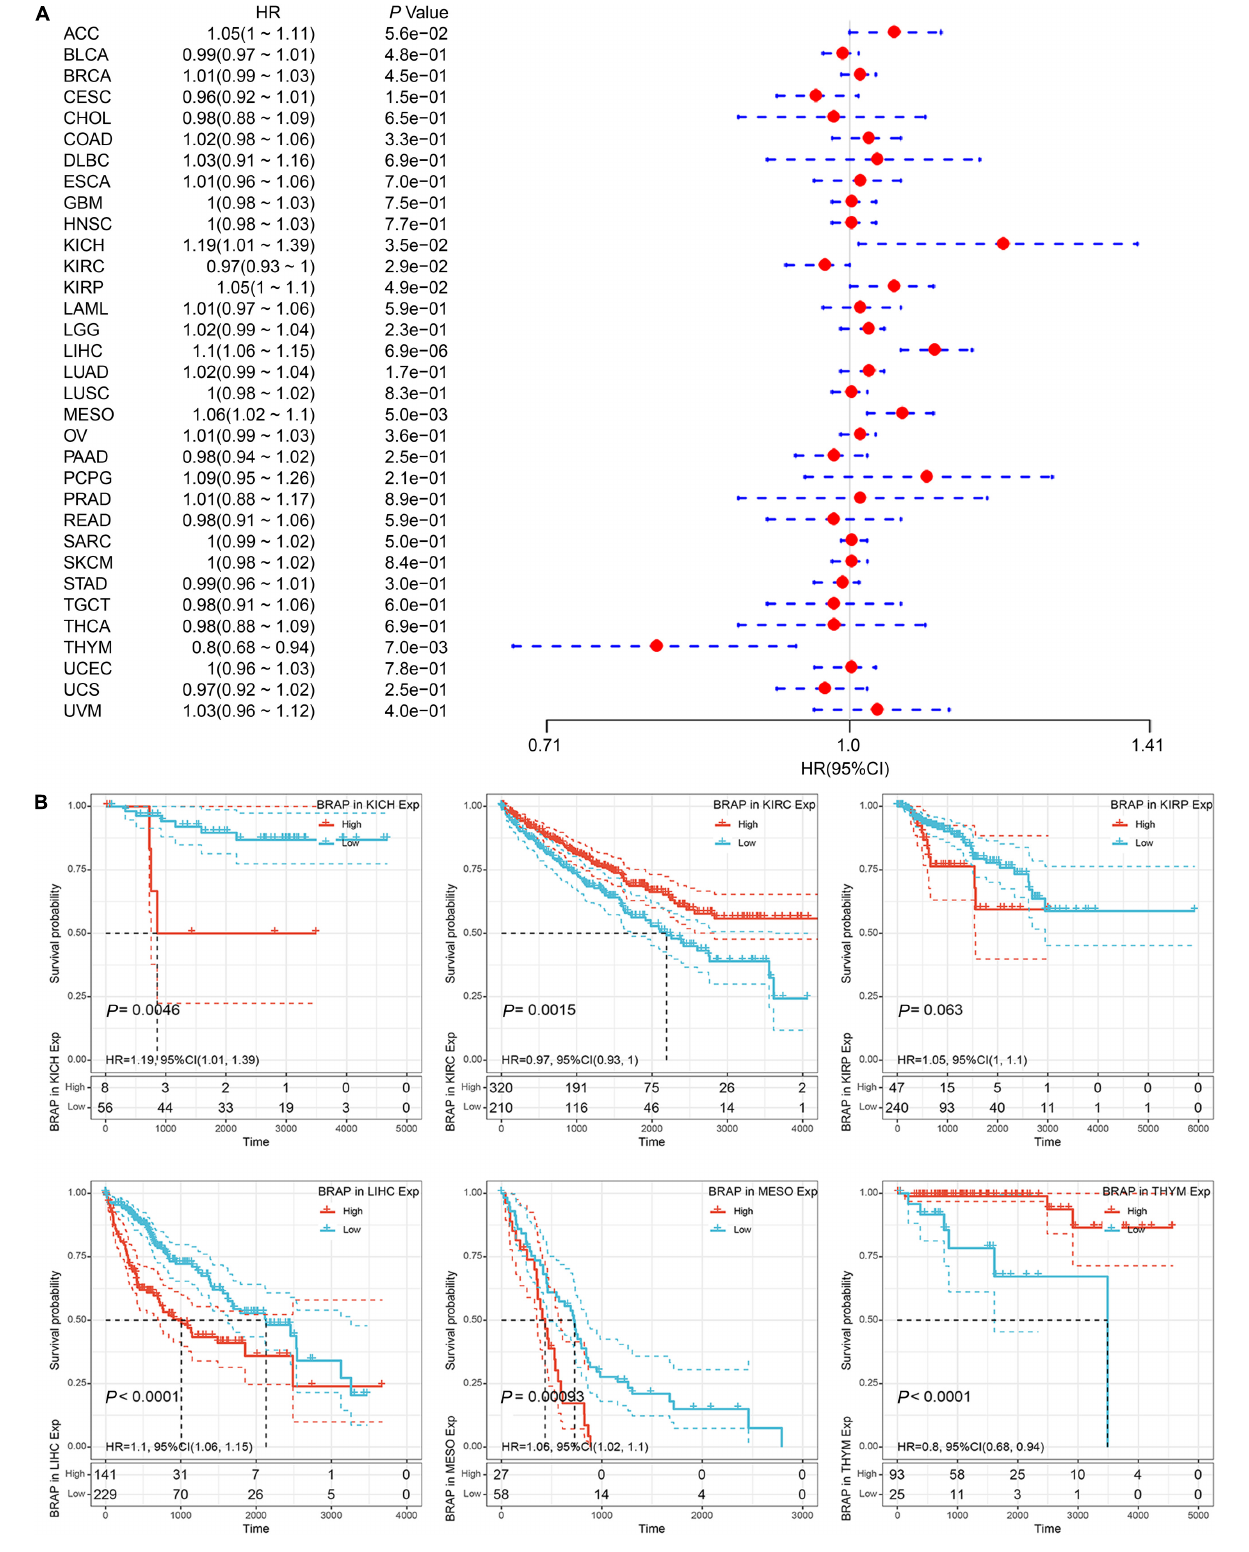
Frontiers in Molecular Biosciences |